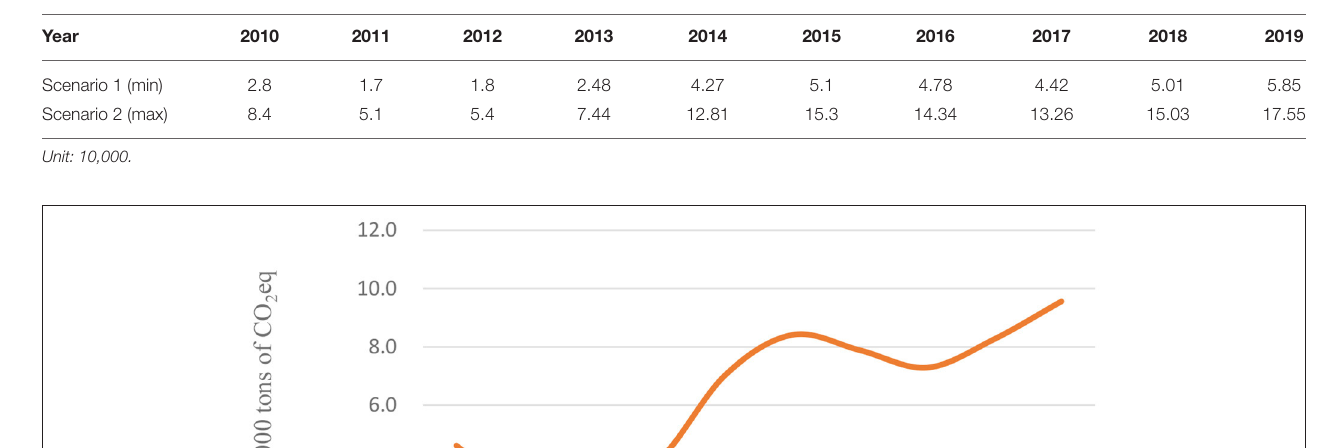
TABLE 2 | Number of remanufactured engines in different scenarios.